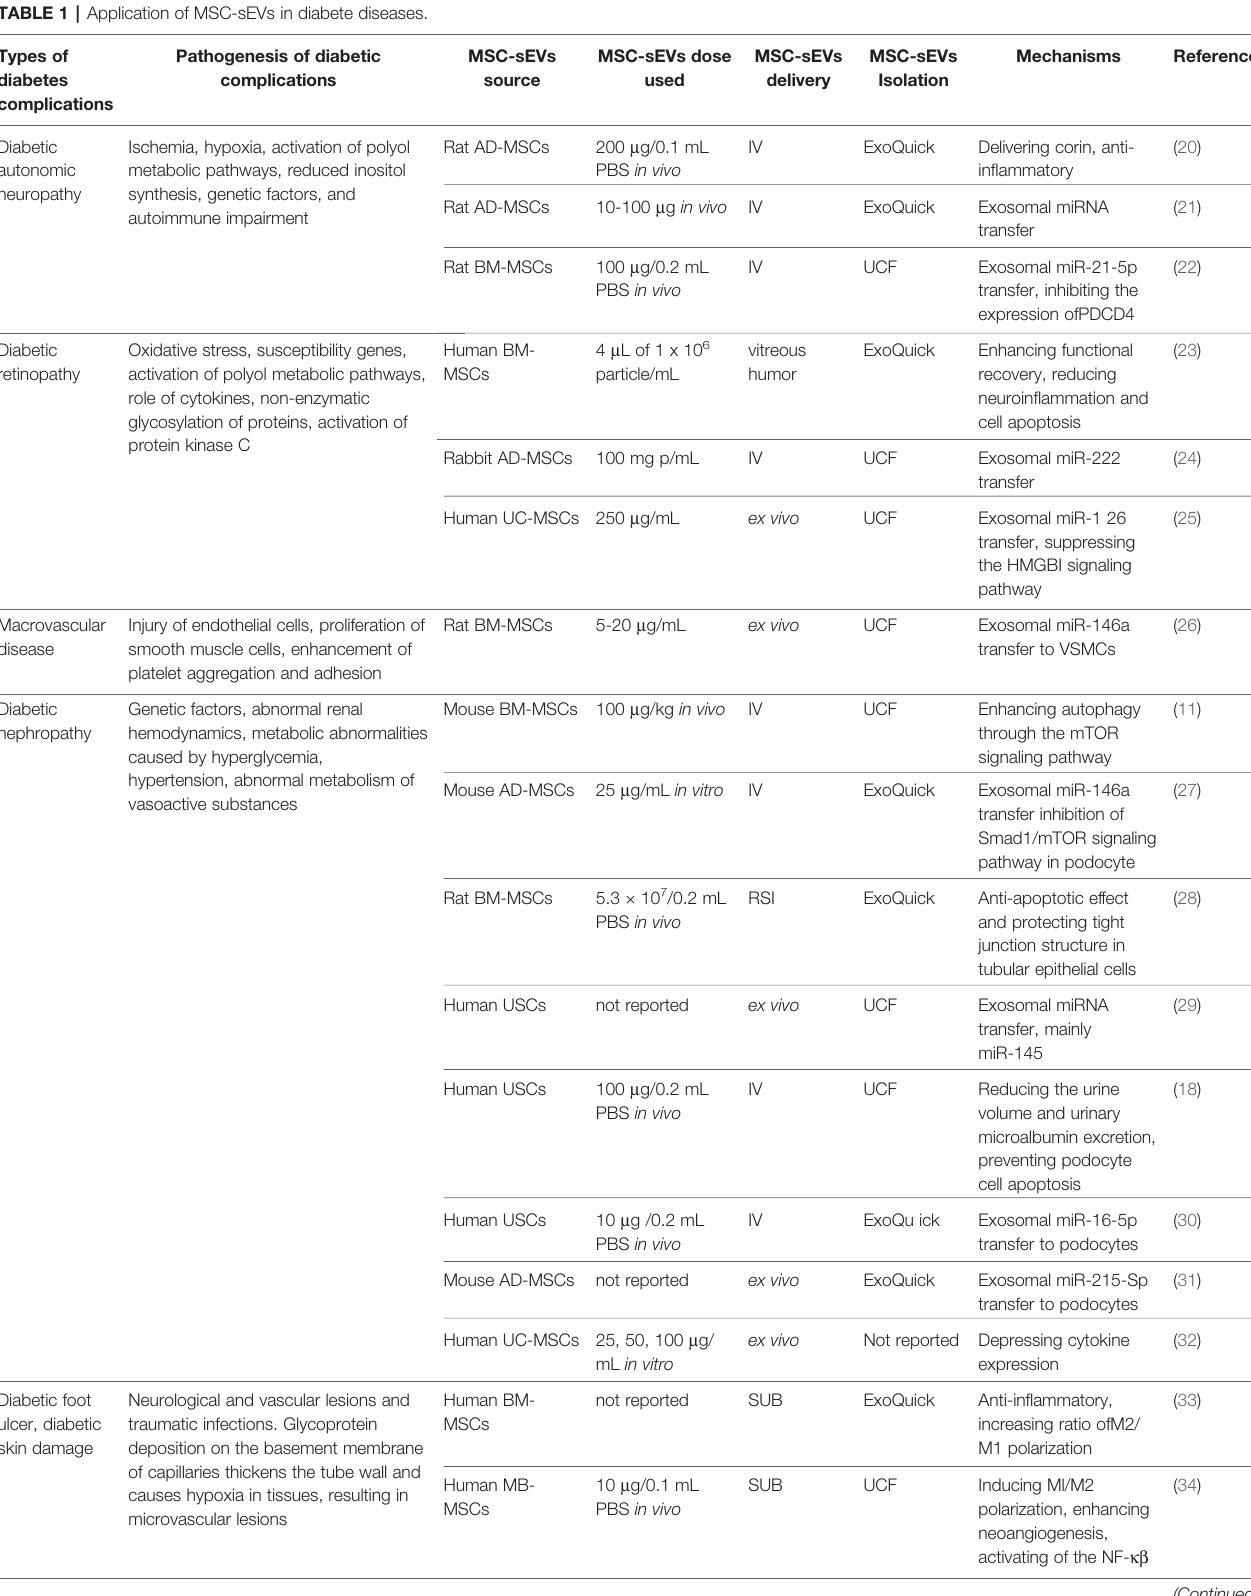
TABLE 1 | Application of MSC-sEVs in diabete